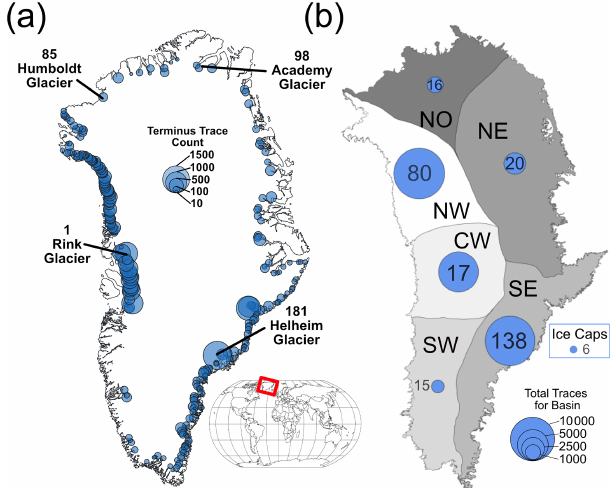
Figure 4. (a) Terminus trace count for glaciers in Greenland. Each circle is centered on a location of a glacier in the TermPicks ID file. The size of the circle reflects the total number of terminus traces available for that glacier. (b) The same data organized by drainage basin. Circle size reflects the total number of traces for that basin. The numbers inside of or adjacent to the circle represent the num- ber of individual glaciers in each basin with terminus traces. Each basin is defined by the ESA/NASA ice sheet mass balance inter- comparison exercise 2016 (IMBIE; Shepherd et al., 2012) which includes basins from Rignot and Mouginot (2012) and Rignot et al. (2011). They are labeled by their geographic location. Region labels are NO = north, NE = northeast, SE = southeast, SW = southwest, CW = center west, and NW =